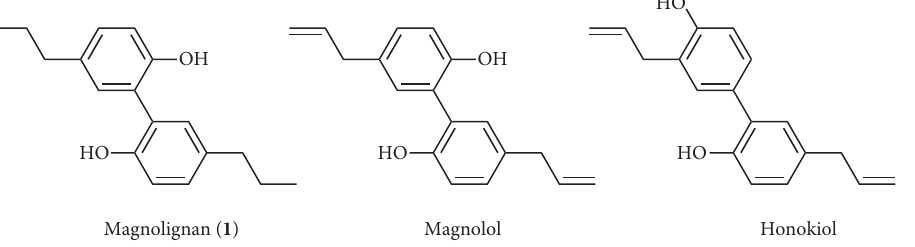
F 1: Structures of magnolignan ( 1 ), magnolol, and